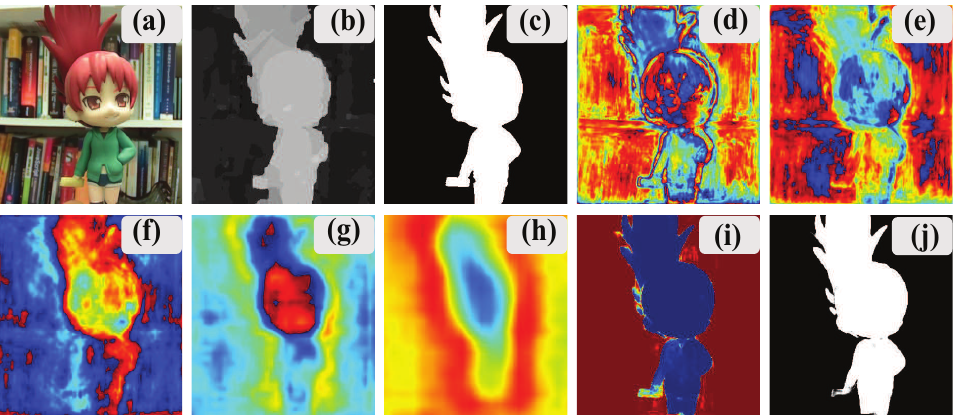
Figure 5. Some visual demonstrations of multi-scale features. The annotations are ( a ) RGB images, ( b ) depth maps, ( c ) ground truth, ( d ) the fused features in the 1st level, ( e ) the fused features in the 2nd level, ( f ) the fused features in the 3rd level, ( g ) the fused features in the 4th level, ( h ) the fused features in the 5th level, ( i ) multi-scale fused features, and ( j ) the predicted saliency